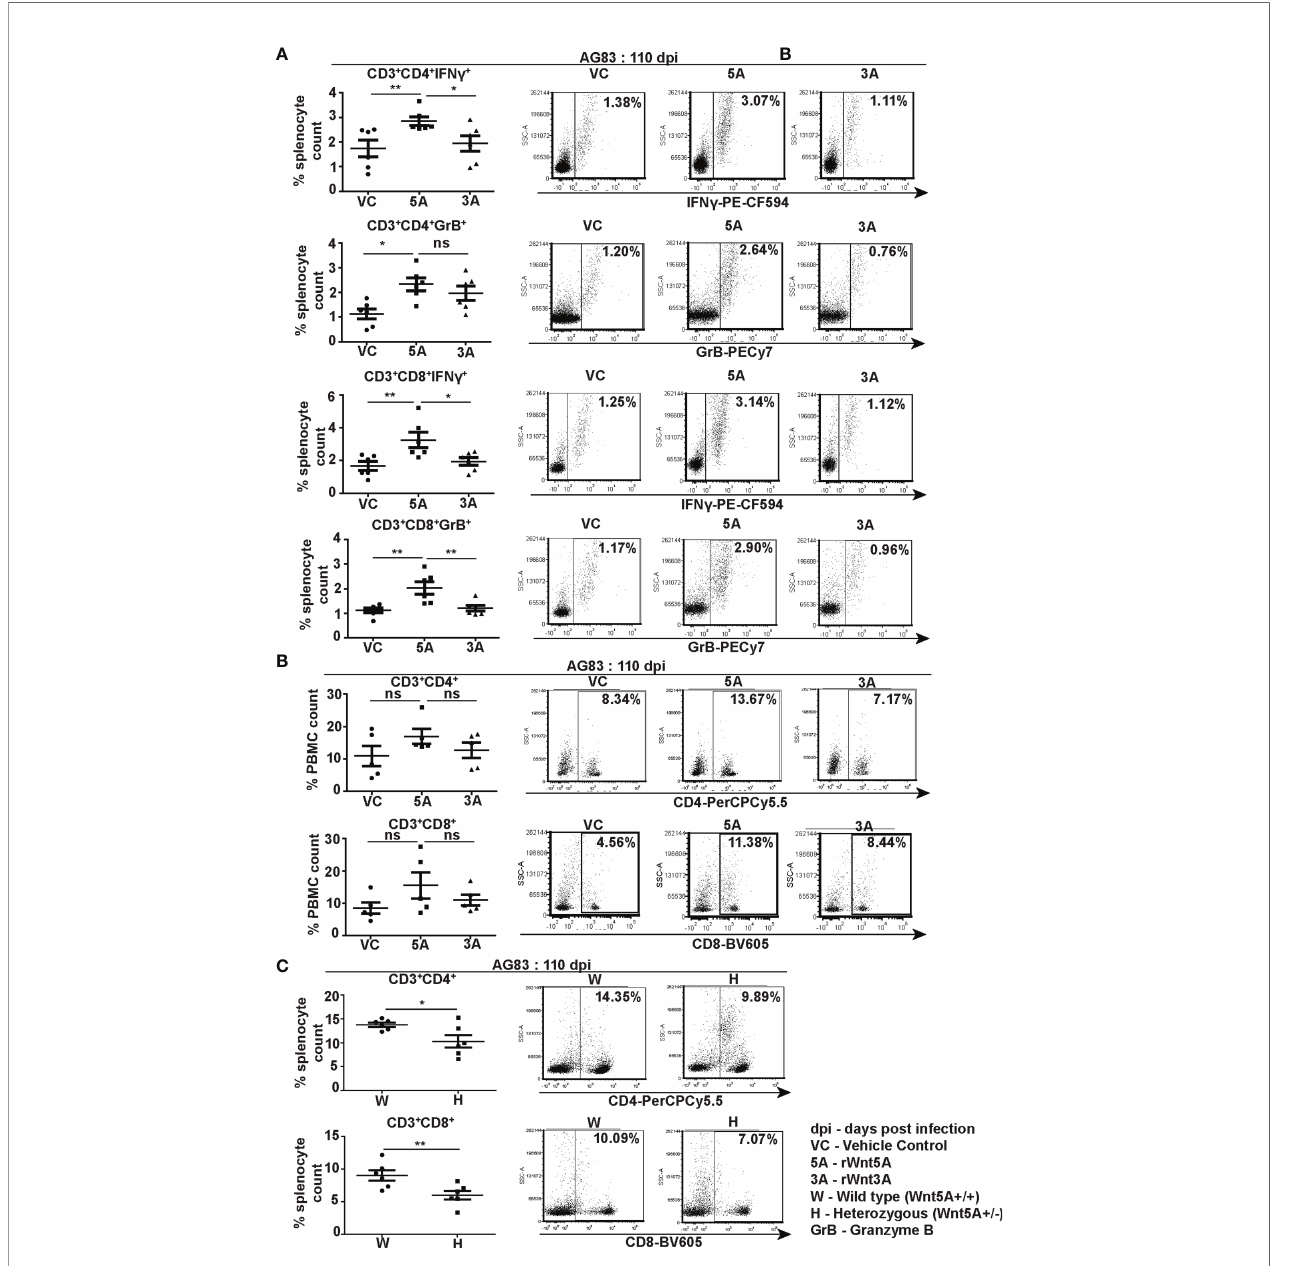
FIGURE 6 | Wnt5A supports CD4 and CD8 T cell maintenance and activation in the backdrop of L. donovani infection. (A) Graphical representation with speci fi c examples depicted as facs dot plots of increased percentage of IFN- g positive and GrB positive splenic CD3 + CD4 + and CD3 + CD8 + T cells subject to rWnt5A treatment before infection, in comparison to the corresponding controls, as depicted by FACS. (B) Representation of a similar trend in the PBMC harvested from the same sets of mice with speci fi c examples depicted as facs dot plots. (C) Graphical representation of lesser percentages of splenic CD3 + CD4 + and CD3 + CD8 + T cells in L. donovani infected H (Wnt5A+/-) mice as compared to the controls (W: Wnt5A+/+) with examples. Data are presented as mean ± SEM. Statistical analysis was performed with the unpaired t-test. Signi fi cance was annotated as follows: * p ≤ 0.05, ** p ≤ 0.005, ns, not signi fi cant, n=5 to 6 (per